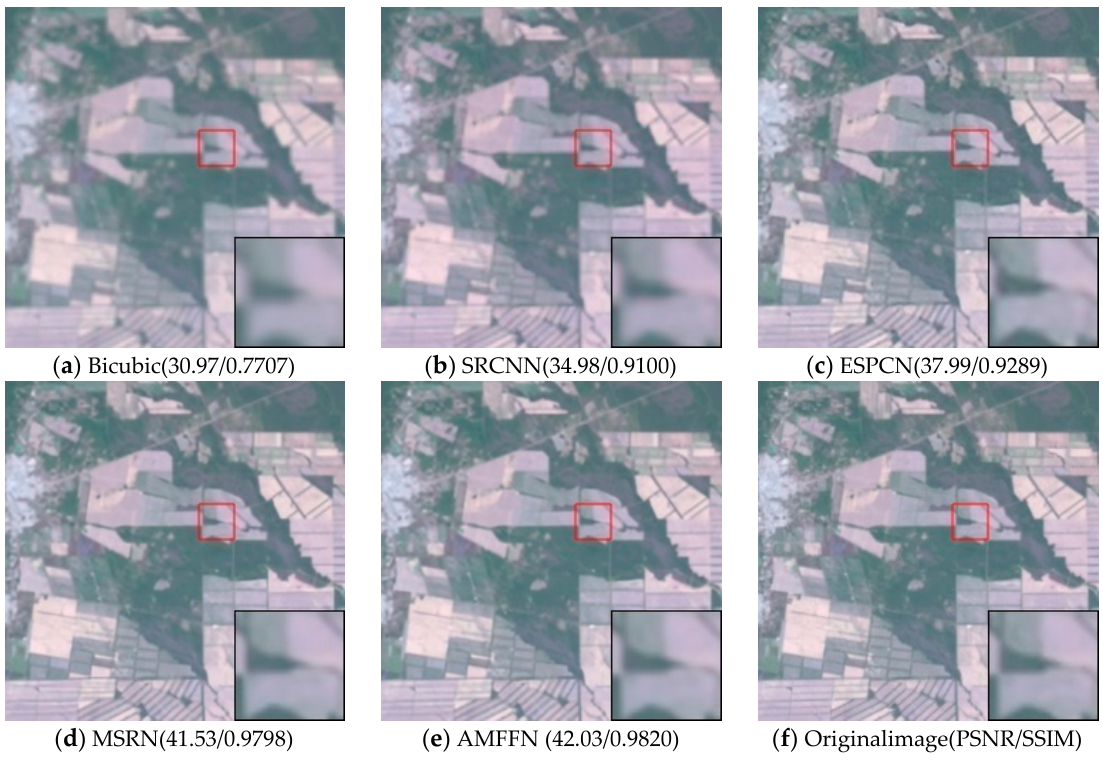
Figure 12. Results of farmland in TG dataset of different methods with scale factor ×2.